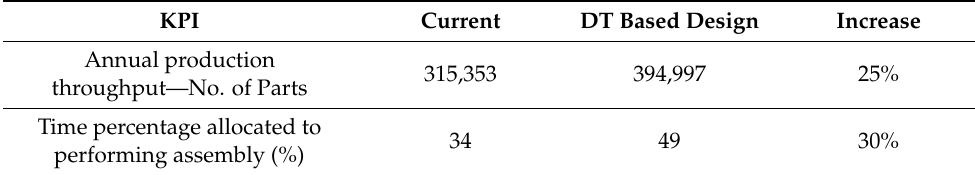
Table 2. Comparison of the two systems—designed system performance.